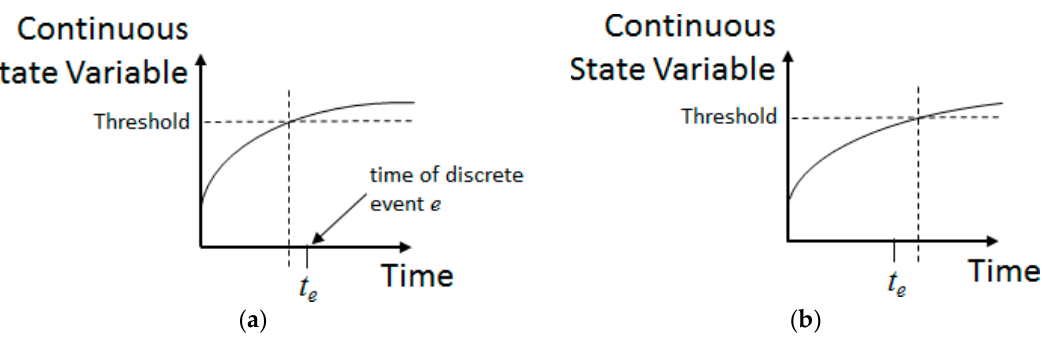
Figure 8. Threshold-crossing event in relation to another event e . Time-adaptive finite di ff erences determine if the threshold is crossed ( a ) before e or ( b ) after e